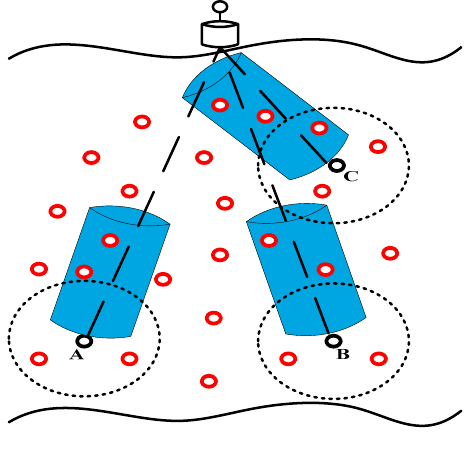
Figure 2. Single pipeline in VBF.